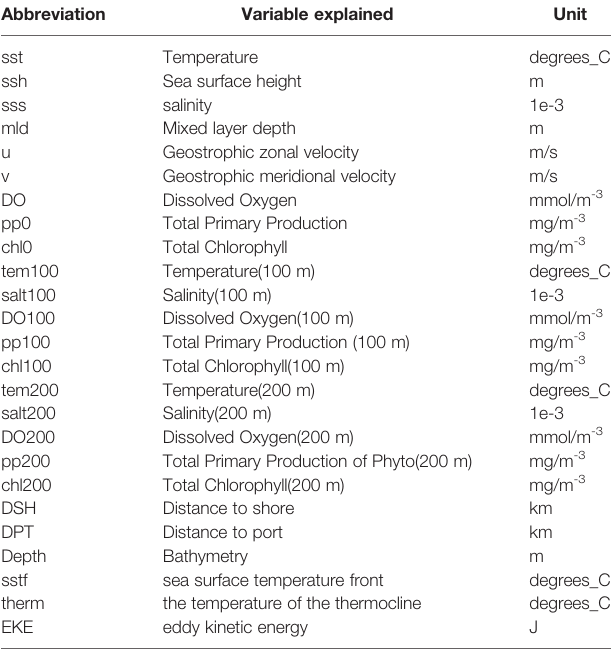
TABLE 1 | List of environmental data.